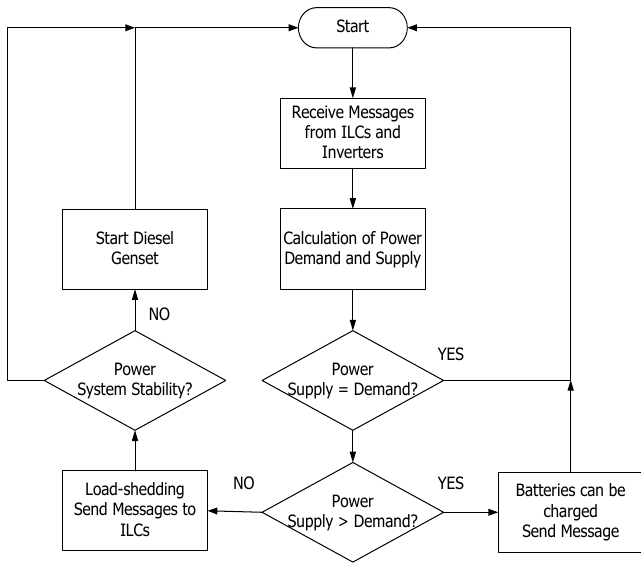
Figure 12. Flow chart of the MGCC algorithm